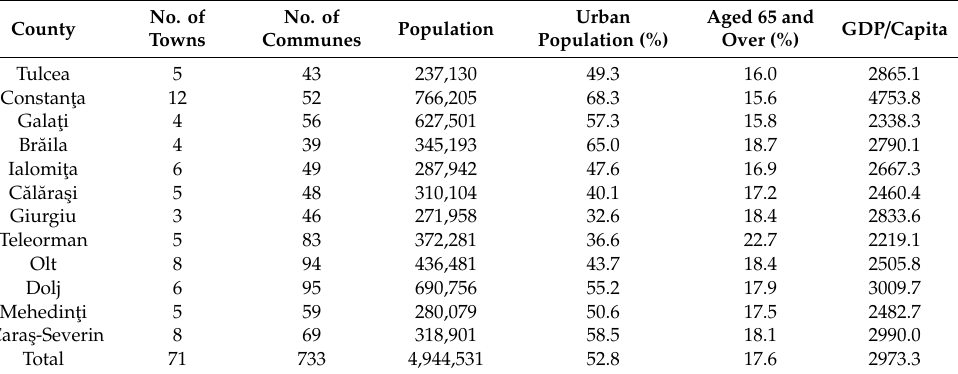
Figure 1. Romanian Danube Valley. Table 1. Key socio–economic features of the study area (county level).